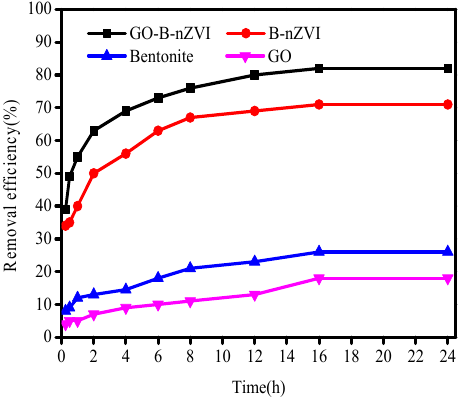
Figure 6. Removal efficiency of Cu(II) by bentonite, GO, B-nZVI, and GO-B-nZVI with time (Temperature = 18 ◦ C; adsorbent dose = 1 g · L − 1 ; pH = 5 ± 0.3; concentration of Cu(II) = 100 mg · L − 1 ).